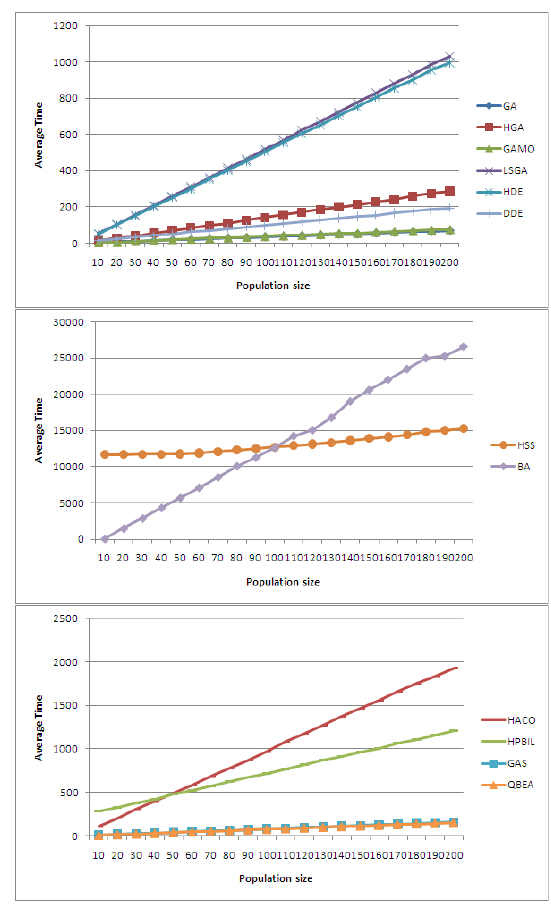
Fig. 5. Results – average time – instance 10. The values have been computed based on 30 different executions for each population size { 10 , 20 , ..., 200 }. For stop criterion we use 1000